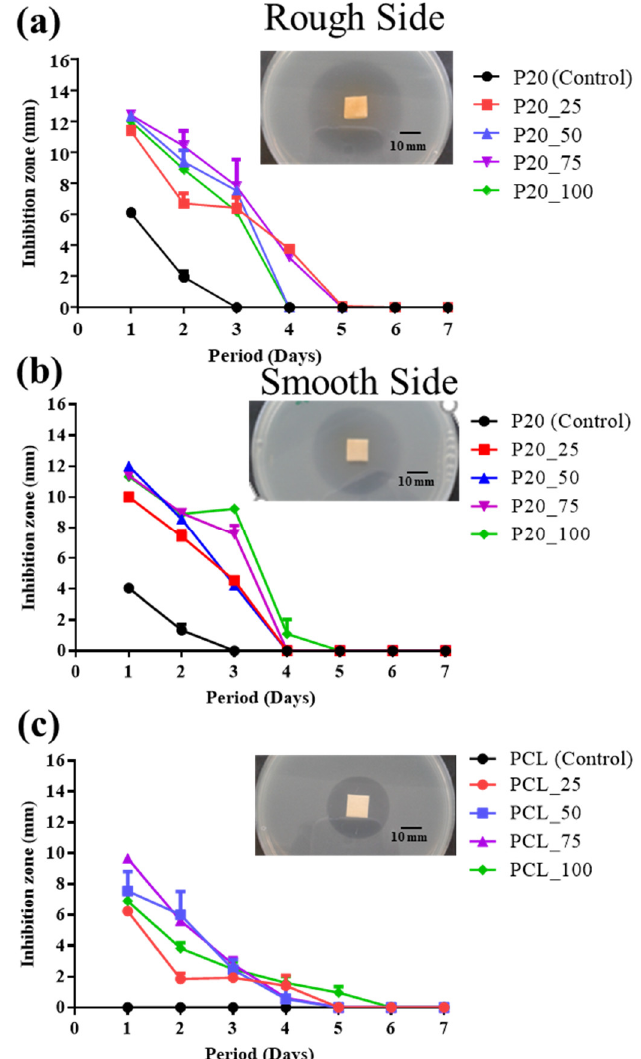
Figure 6. Antibacterial activity of cefazolin loaded samples against S. aureus as indicated by inhibition zone: ( a ) Rough side of cefazolin loaded ORC/PCL bilayered composite; ( b ) smooth side of cefazolin loaded ORC/PCL bilayered composite; ( c ) cefazolin loaded PCL. Bar = 10 mm.